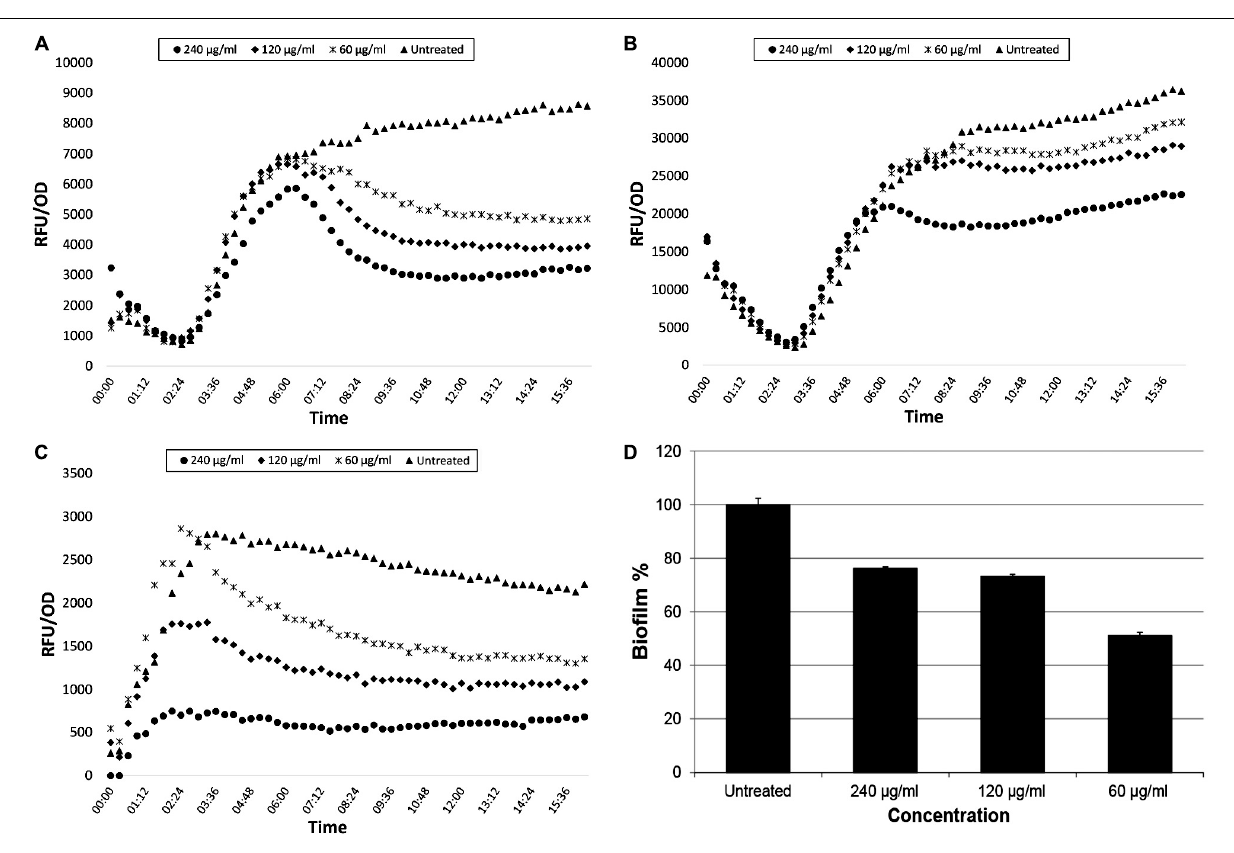
FIGURE 4 | GFP expression curves of lasB-gfp, rhlA-gfp , and pqsA-gfp monitor strains ( A–C , respectively) and biofilm inhibition percentage (D) of PAO1 strain treated with trans- 4-(2-carboxy-vinyl) benzoic acid isolated from N. versiforme